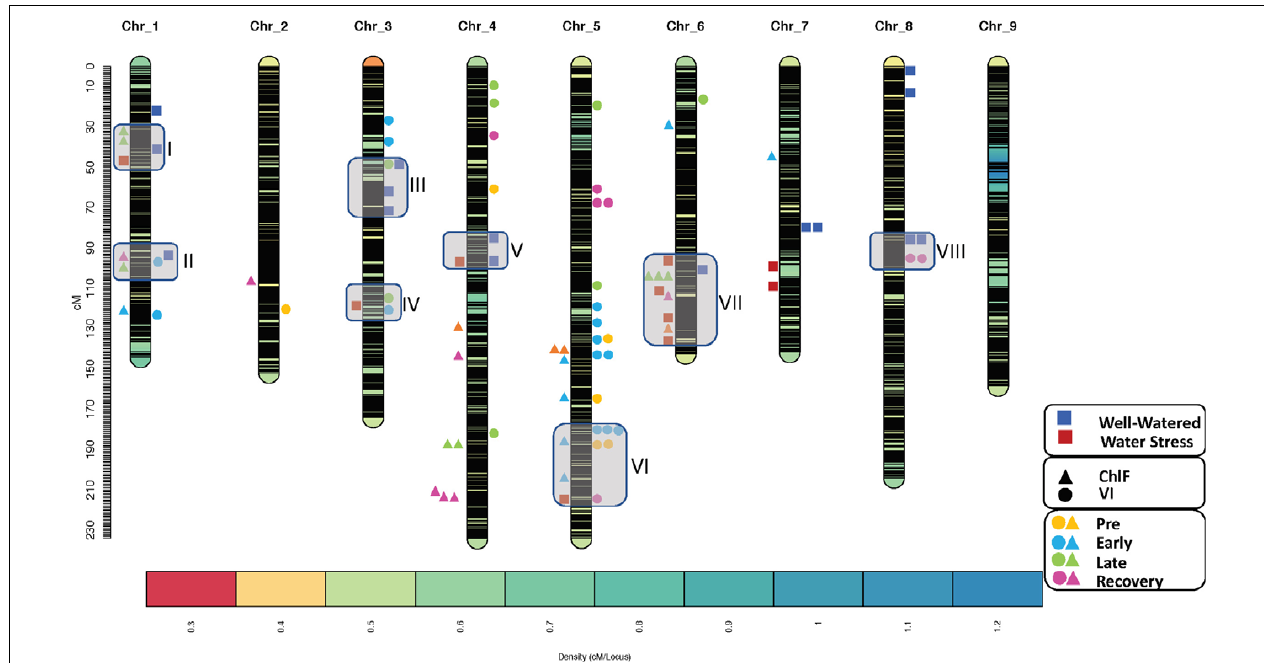
FIGURE 4 | Genomic location of the QTL clusters identified in this study. Color of the legends represent different treatments and the shape of these legends represent phenotypic traits (square: horticultural traits, tringle: chlorophyll fluorescence parameters, and circle: vegetation indices). The boxes on the SNP marker-based lettuce density map represent QTL